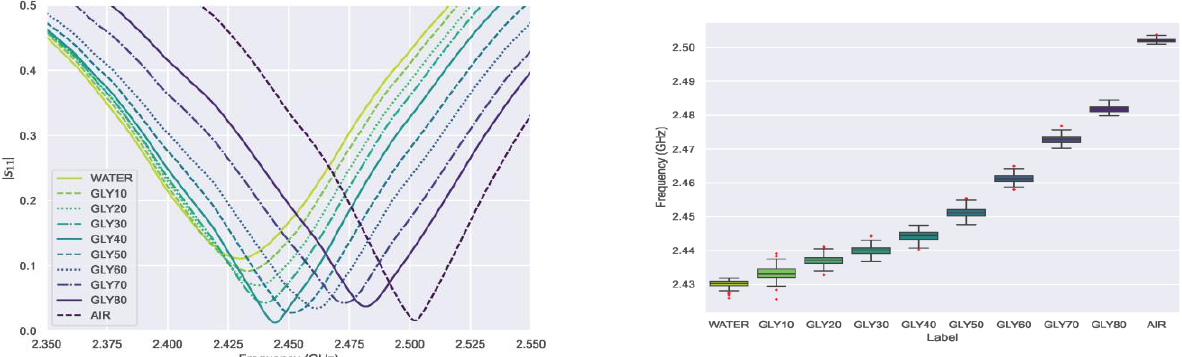
Figure 6. VNA average signals ( left ) and boxplot of the resonance peak distribution ( right ) for each glycerin